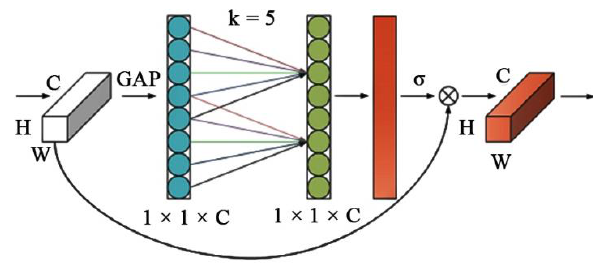
Figure 4. Structure of the Efficient Channel Attention Module.